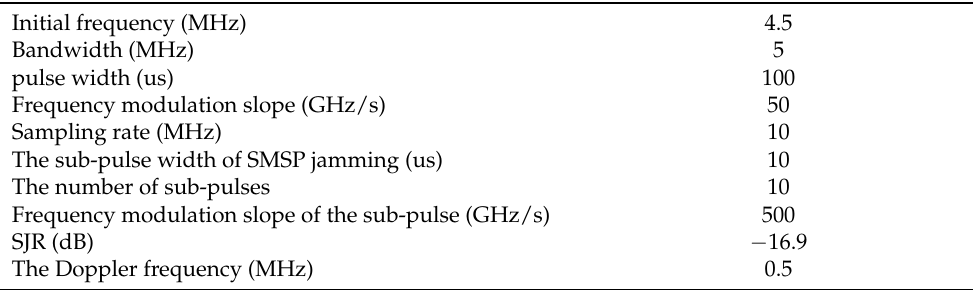
Table 2. Simulation parameters.